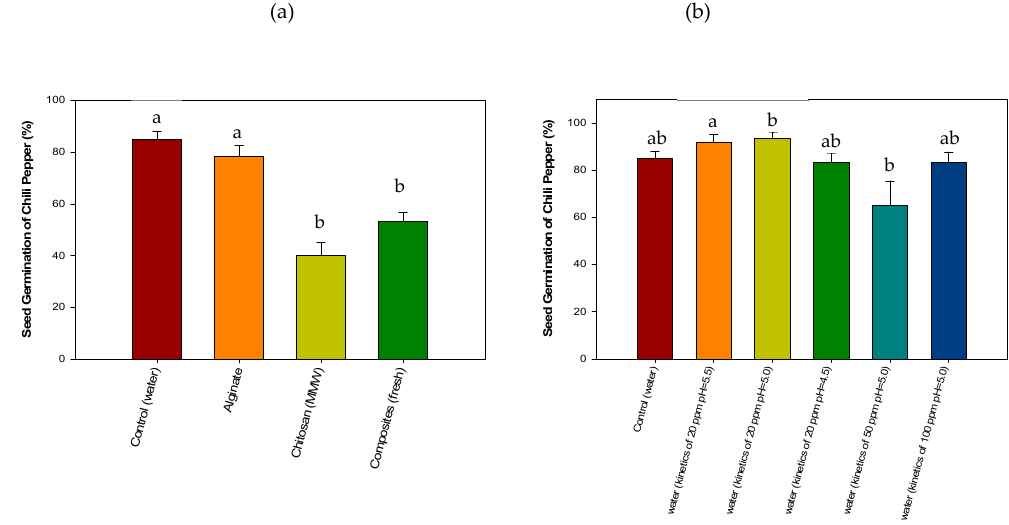
Figure 8. Evaluation of the toxicity of composite beads ( a ) and simulated wastewater after copper removal treatment ( b ) on the germination of Capsicum annuum seeds.